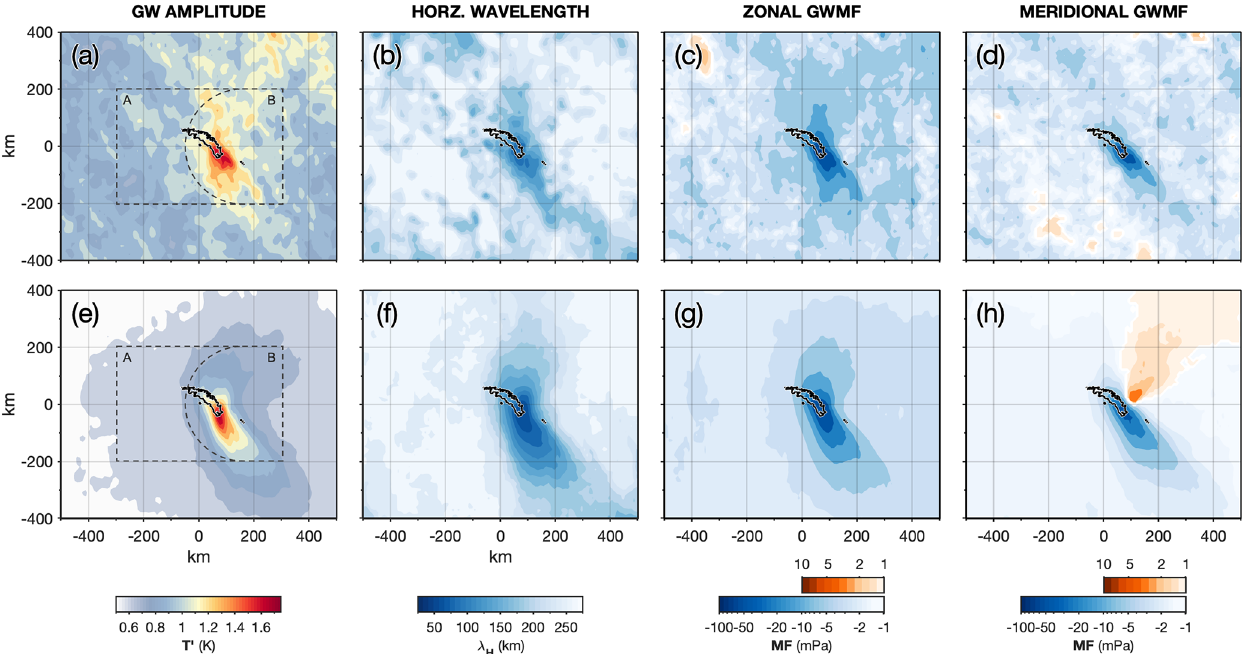
Figure 9. Average GW temperature amplitudes T (cid:48) , horizontal wavelengths λ H , and zonal and meridional momentum flux (GWMF) MF x and MF y over South Georgia from AIRS measurements (a–d) and the model sampled as AIRS (e–h) during both modelling campaigns in July 2013 and June–July 2015. Data are averaged over a vertical region between 25 and 45km altitude. For horizontal wavelengths, only λ H measurements for GWs with amplitudes T (cid:48) > 1 . 5K are included in the average. Black dashed lines in (a) and (e) show the extent of the regions described in Fig.